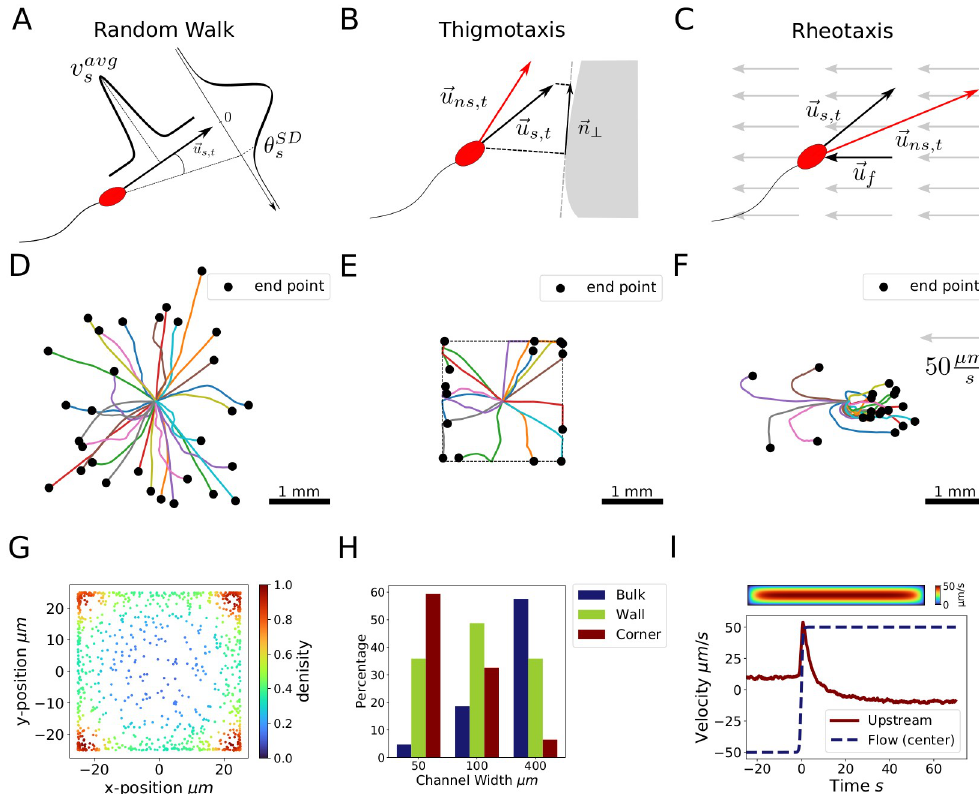
Fig 2. Agent movement, interaction rules, and resulting trajectories in a box. A In each time step, agents draw velocities and angles from normal distributions defined by v avg and y SD . B Thigmotaxis is described by averaging the agents s s orientation vector ~ u with its projection on the tangent plane of the compartment wall ~ n , providing the new agent ? s ; t . C Positive rheotaxis is implemented by subtracting the fluid orientation vector ~ u from the sperm orientation ~ u ns ; t f orientation ~ u (Supplementary Note B in S1 Text). D-F Agent movement simulated in a box (120 μ m height): agents started s ; t in the center, black dots depict final positions. Simulated time was 30 s each. D Random walk E Thigmotaxis: agent movement restricted by walls (box width and length were set to 2 mm indicated by dashed lines). Agents adapt their orientation when hitting walls. F Positive rheotaxis: facing a fluid flow of 50 m m (direction indicated by arrow), agents s reoriented into the flow and moved against it. G Cross-sectional distribution of agents ( N = 1000), simulated in a channel with a width and height of 50 μ m. Agent density increases towards boundaries and corners. H Depending on their distance to channel boundaries, agents were classified as corner, wall or bulk swimmers. With increasing channel size the percentage of corner swimming sperms decreased, while the fraction of bulk swimming sperms increased. I Agents were exposed to a fluid flow reversal in a channel with a rectangular cross-section of 34 μ m times 300 μ m. The net upstream velocity was analysed for comparison with [24]. After an initial peak on fluid reversal agents re-orientate within 30 s. The inset represents the fluid velocity profile calculated by Eq S41 in S1